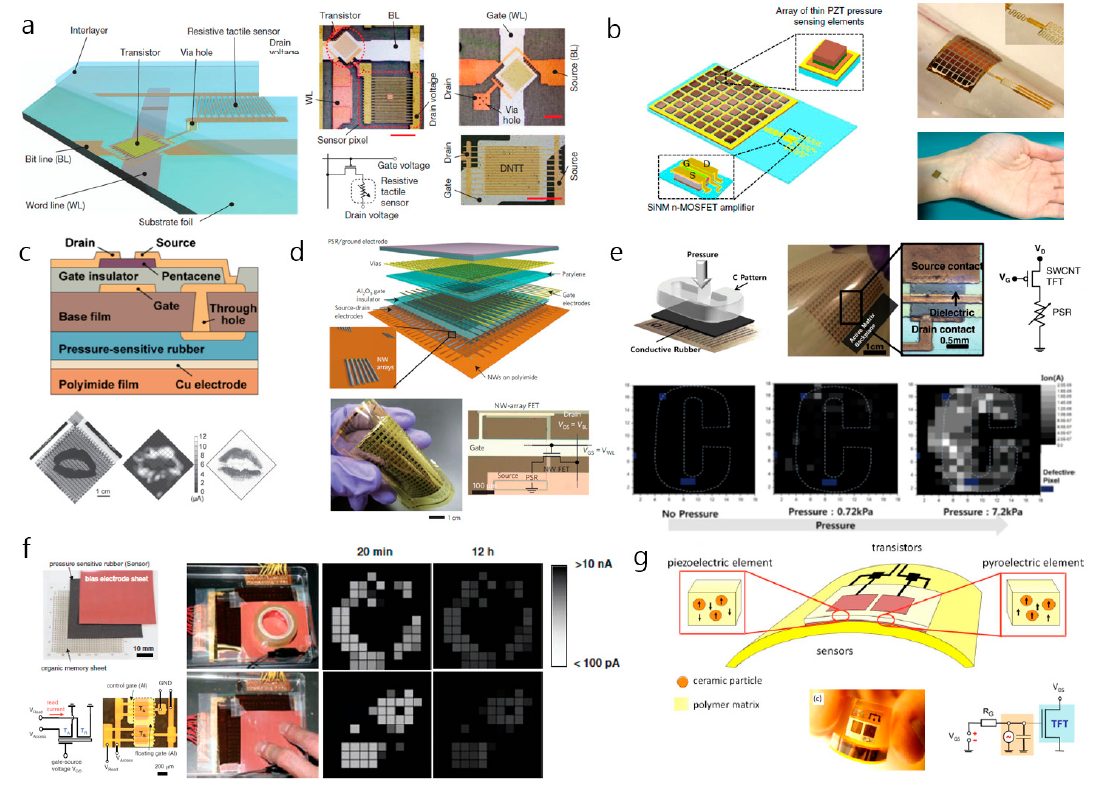
Figure 4. F ield-effect transistor (FET)-based tactile sensor arrays with pressure-sensing components. ( a ) Active-matrix tactile pixel sensor comprising a switching transistor and a resistive touch sensor. ( b ) Thin conformal array pressure sensor made of elements of zirconate titanate (PZT) with transistor